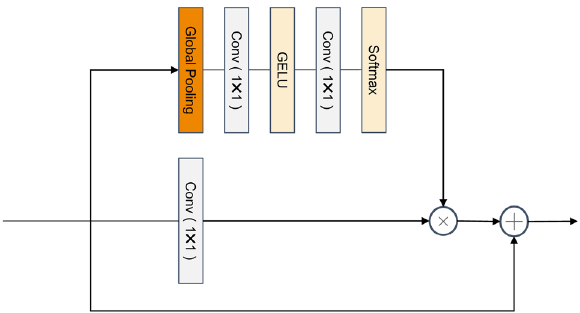
Figure 4. The details of spatial attention